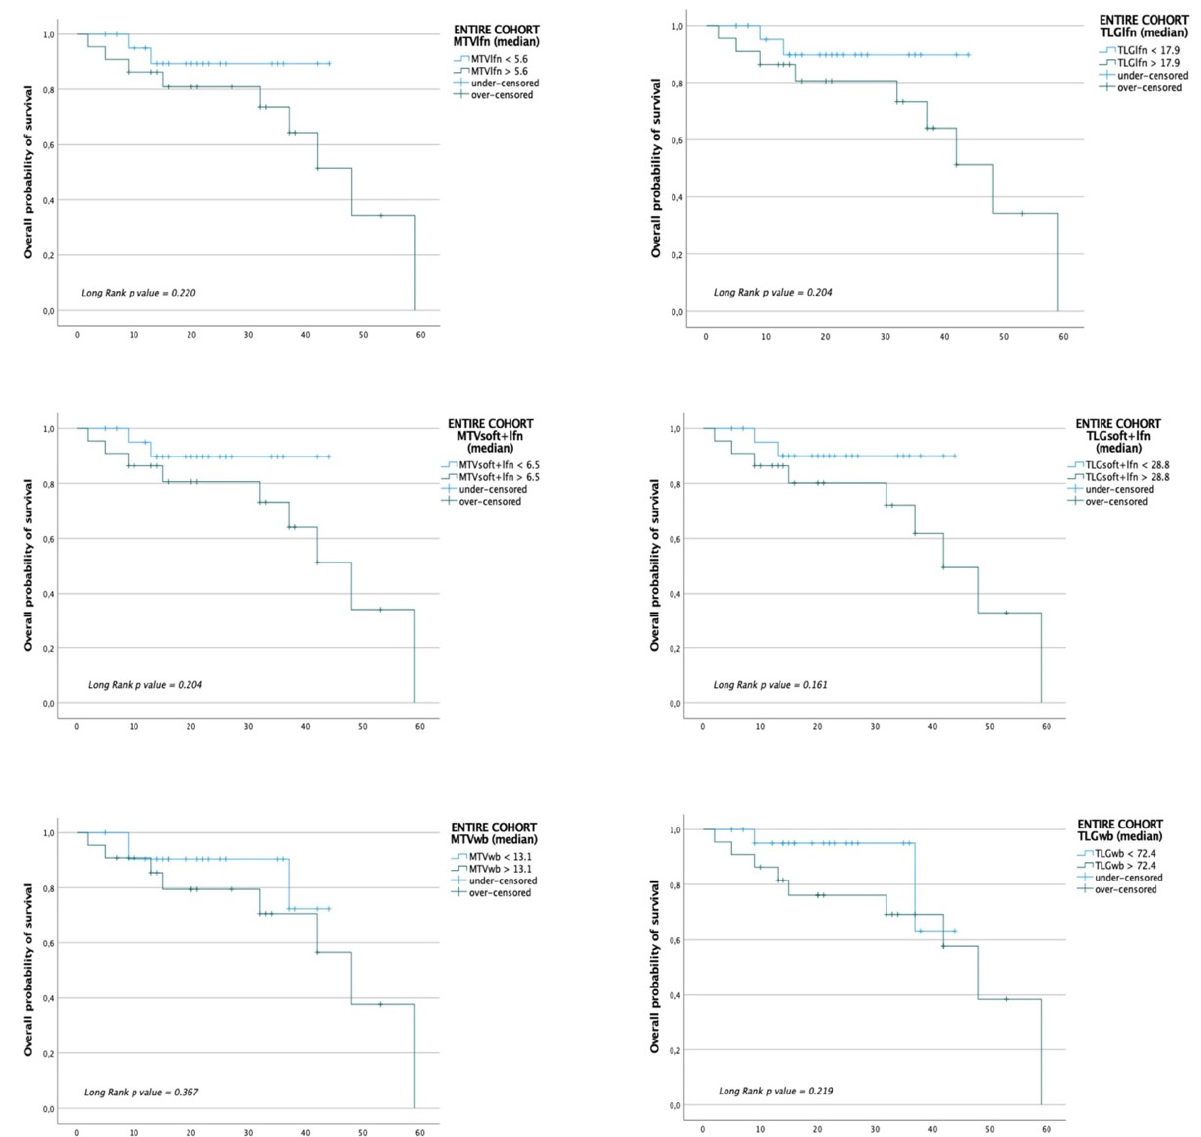
Figure 3. Kaplan–Meier plot analysis for whole-body and district MTV and TLG with overall survival (OS) in the entire cohort. Population was grouped by the median